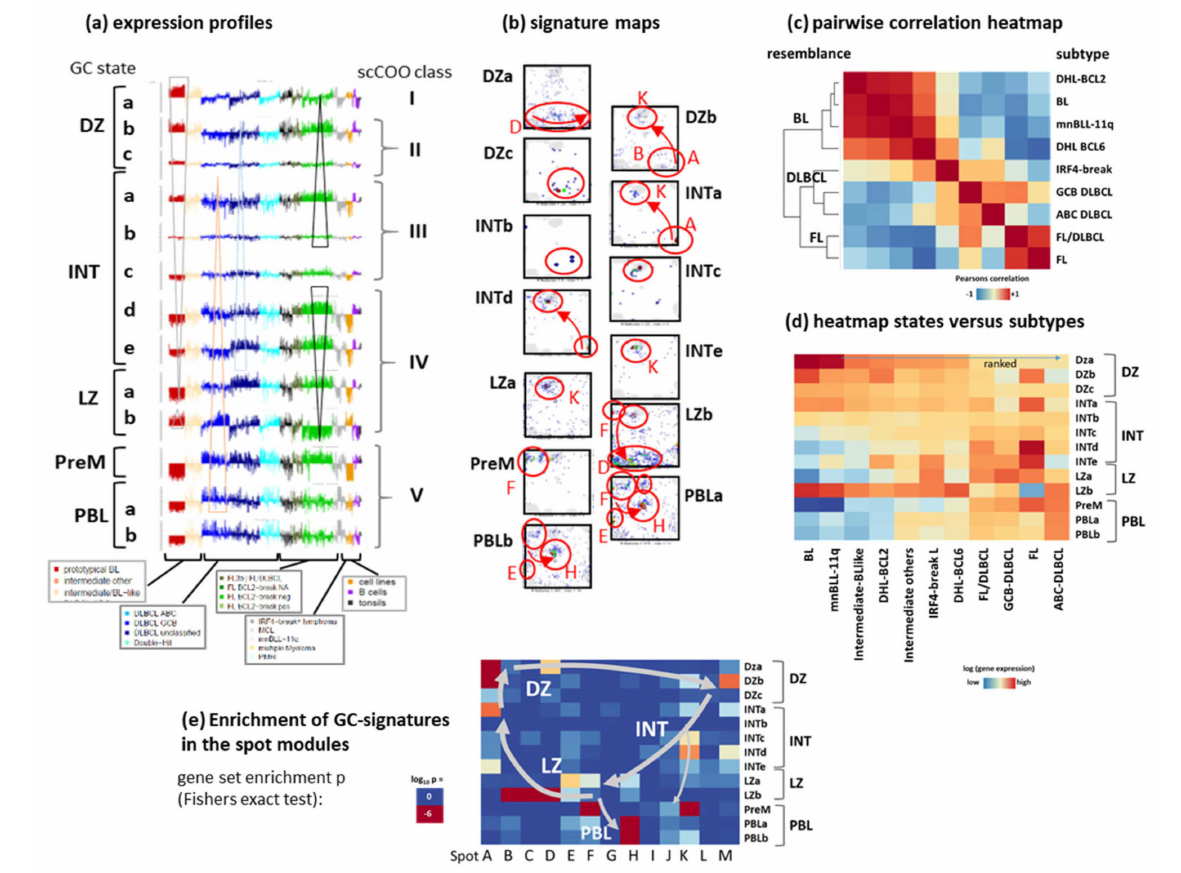
Figure 3. Gene expression signatures of the multistate model of Holmes et al. [24]: ( a ) GSZ-profiles of the 13 GC cell states across the lymphoma tumors. It divides into transcriptional states of GC B-cells distributing across the LZ, DZ and intermediate (INT) GC compartments and in addition, states referring to precursor memory (PreM) and plasmablast (PBL) cells, both showing commitment towards memory and plasma cells, respectively. Tumors of each subtype were ranked with increasing cell cycle activity from the left to the right. scGC signatures were taken from [24] (Table S2 there, UP signatures). ( b ) Maps of the signature genes of the scGC-states. Areas of accumulation are shown by ellipses. The GC reaction can be summarized into a closed circle in the SOM (see arrows and Figure 2). ( c ) The heatmap visualizes mutual similarities between the mean SOM expression portraits of different lymphoma strata. The most prominent cluster collects BL- and FL-resembling subtypes with DLBCL-like subtypes in between. ( d ) Clustered heatmap of the mean expression of the GC-states versus the lymphoma subtypes. ( e ) Enrichment of GC-state signature sets in the spot modules (log p values, Fishers exact test). Spots with enriched signatures (brown areas in the heatmap) form the GC-reaction circle shown in the landscape in Figure 2d; see also Figure